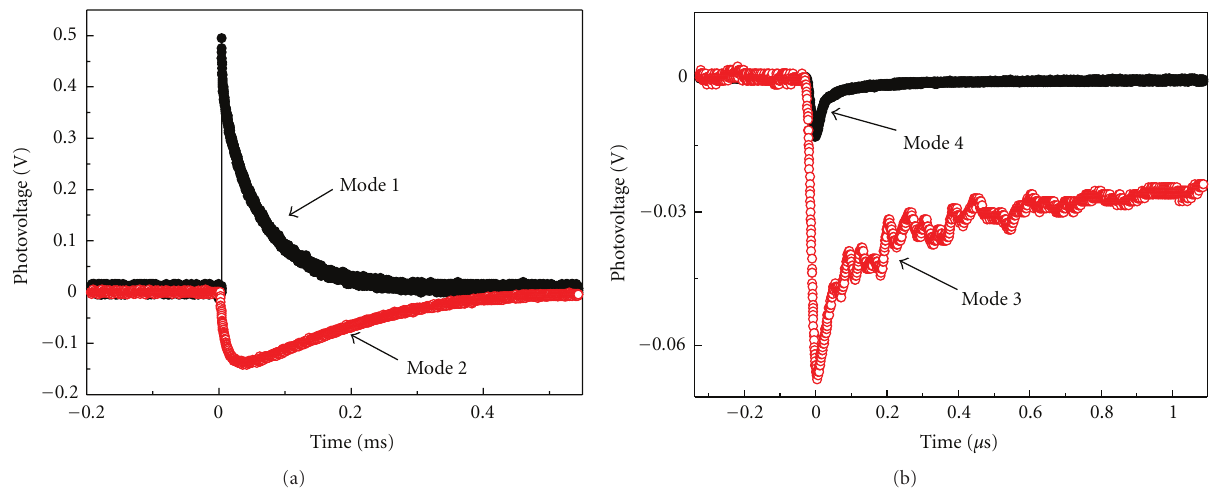
Figure 3: Typical photovoltaic pulses as functions of time for LCMO/LSAO sample.